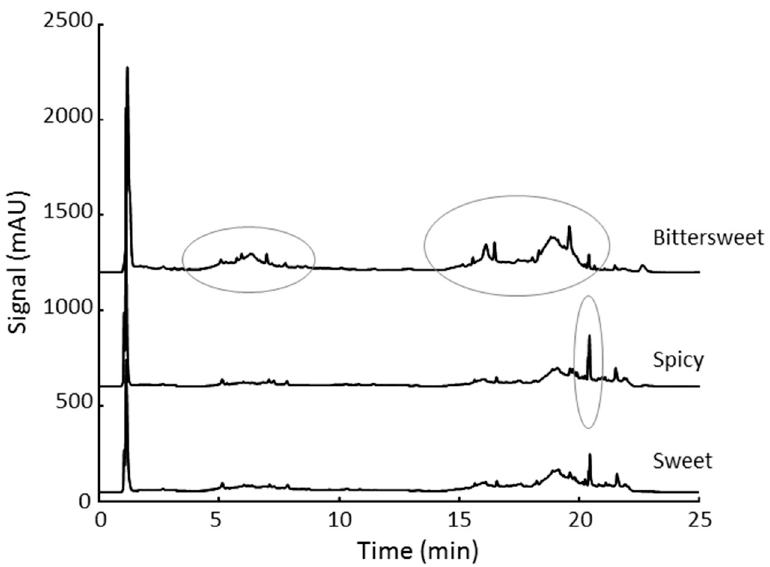
Fig. 2. Representative chromatograms obtained for certain arbitrary paprika samples extracts. Figure 2. Representative chromatograms obtained for certain arbitrary paprika samples